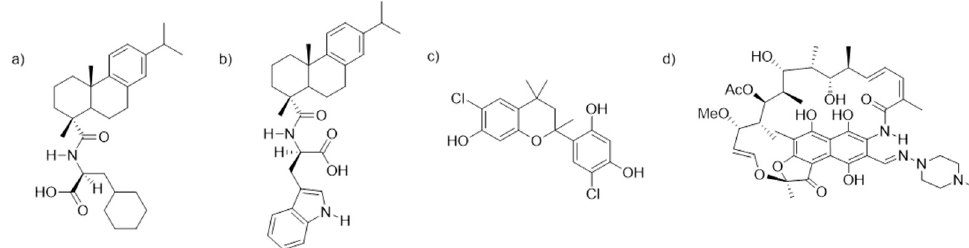
Figure 1. Chemical structures of the two dehydroabietic acid (DHA) derivatives, ( a ) N